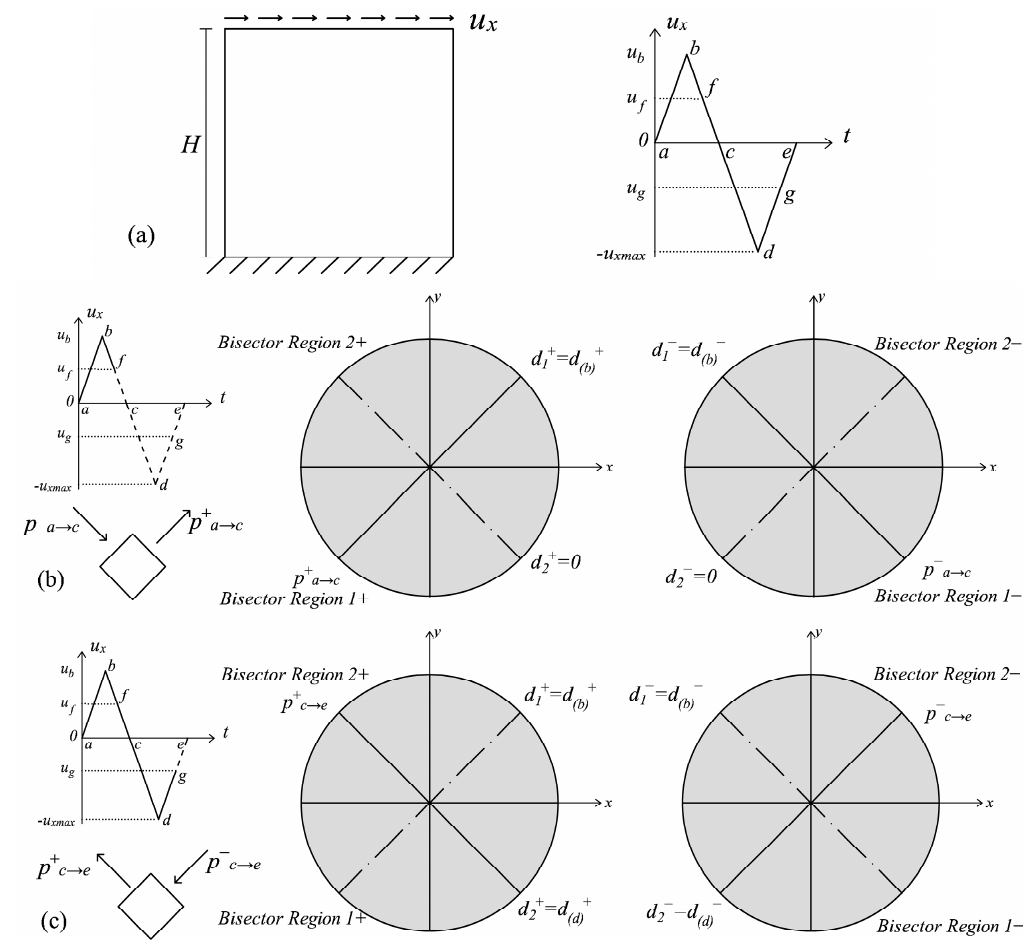
Figure 4. Multidirectional damage procedure in the case of cyclic loading of Type (i): ( a ) problem statement; ( b ) identification of the damage regions and damage variables before the load reversal and ( c ) after the load reversal.